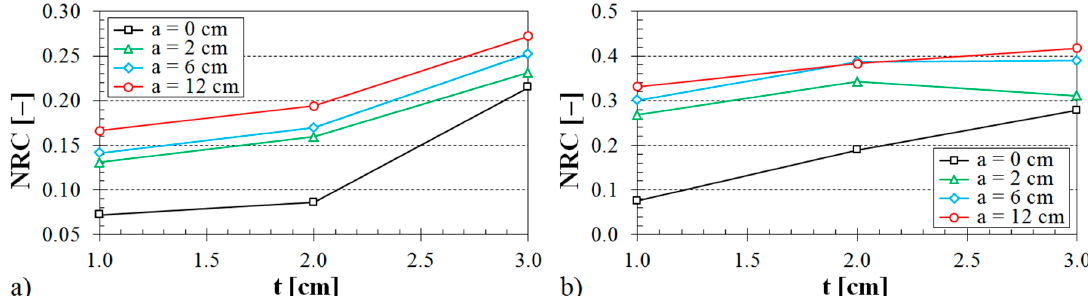
Figure 12. Influence of the air space size on the noise reduction coefficient vs. material thickness for the investigated ABS samples: ( a ) Rhomboid structure, volume ratio V r = 44%; ( b ) Cartesian structure, volume ratio V r = 70%.